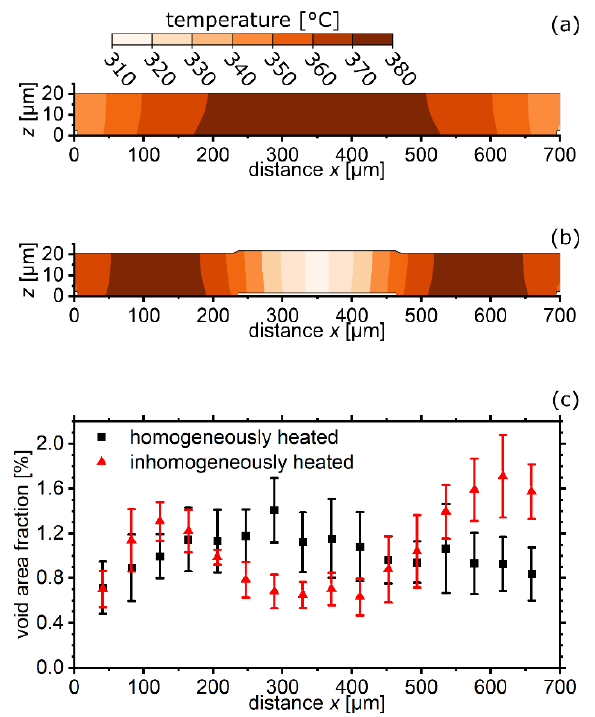
Figure 5. ( a ) Cross-sectional temperature distribution in the Cu layer of ( a ) a homogeneously heated and ( b ) an inhomogeneously heated poly-heater, simulated by finite element method [65]. ( c ) Profile of void area fraction along the lateral direction of the investigated poly- heaters’ Cu